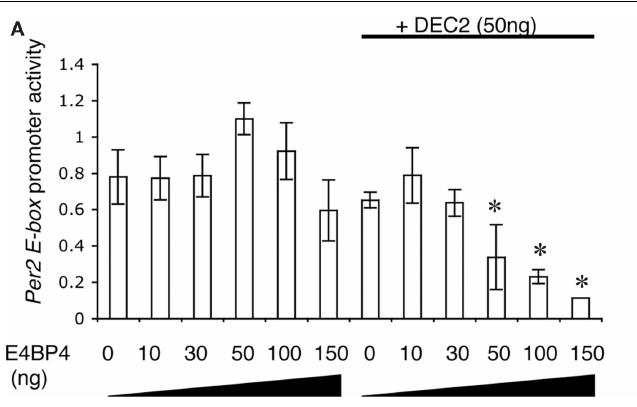
relative values of the Per2EE promoter-driven luciferase activity compared to internal control luciferase activity (pRL-TK). E4BP4 repressed the Per2 EE element-driven promoter activity in the presence of DEC2 (A) . DEC2 repressed the Per2 EE element-driven promoter activity in the presence of E4BP4 (B) . Error bars represent SEM from three independent experiments. Asterisk (*), p < 0.05 versus 0ng of E4BP4 or DEC2.